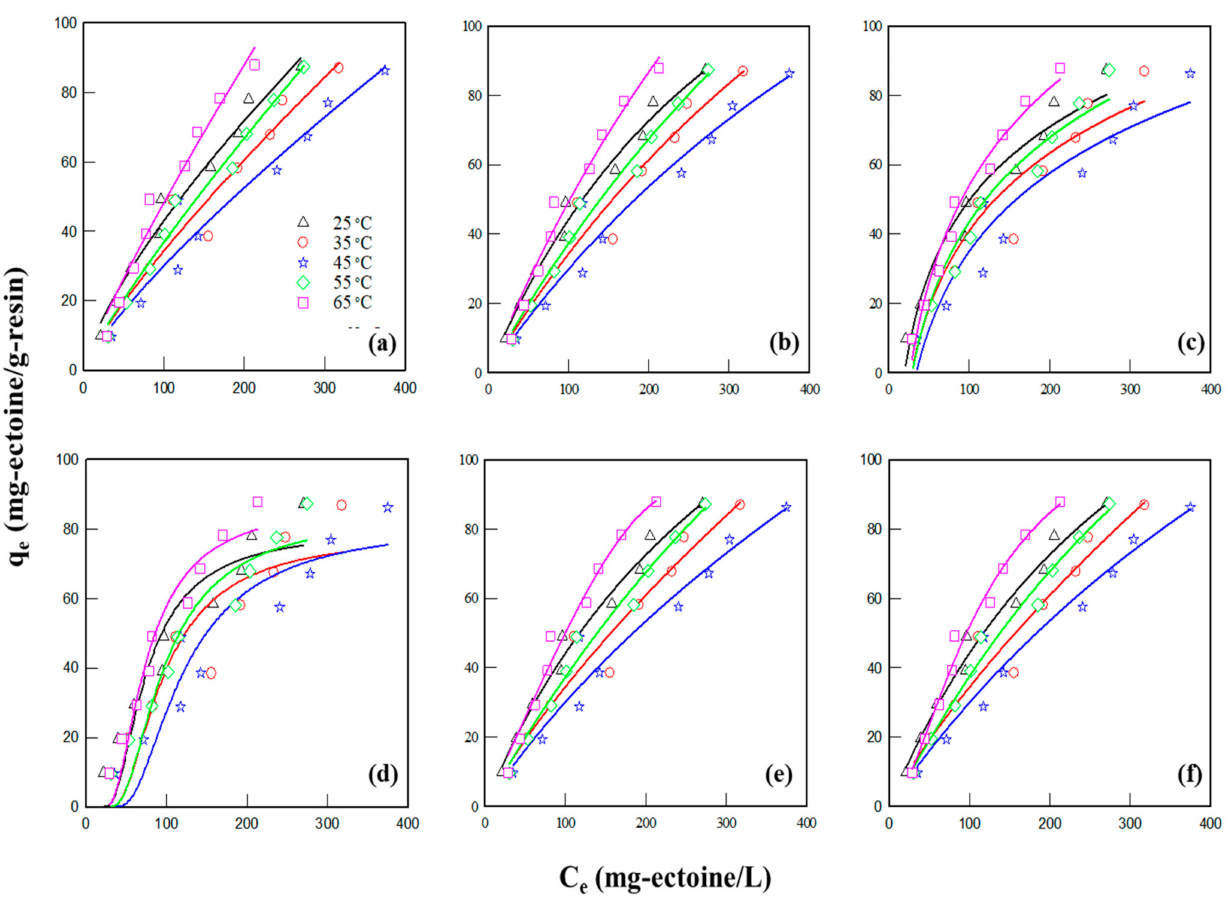
Figure 5. Nonlinear regression fitting curve using the isotherm models ( a ) Freundlich, ( b ) Langmuir, ( c ) Temkin, ( d ) D–R, ( e ) R–P, and ( f ) Sips for the simulation of ectoine